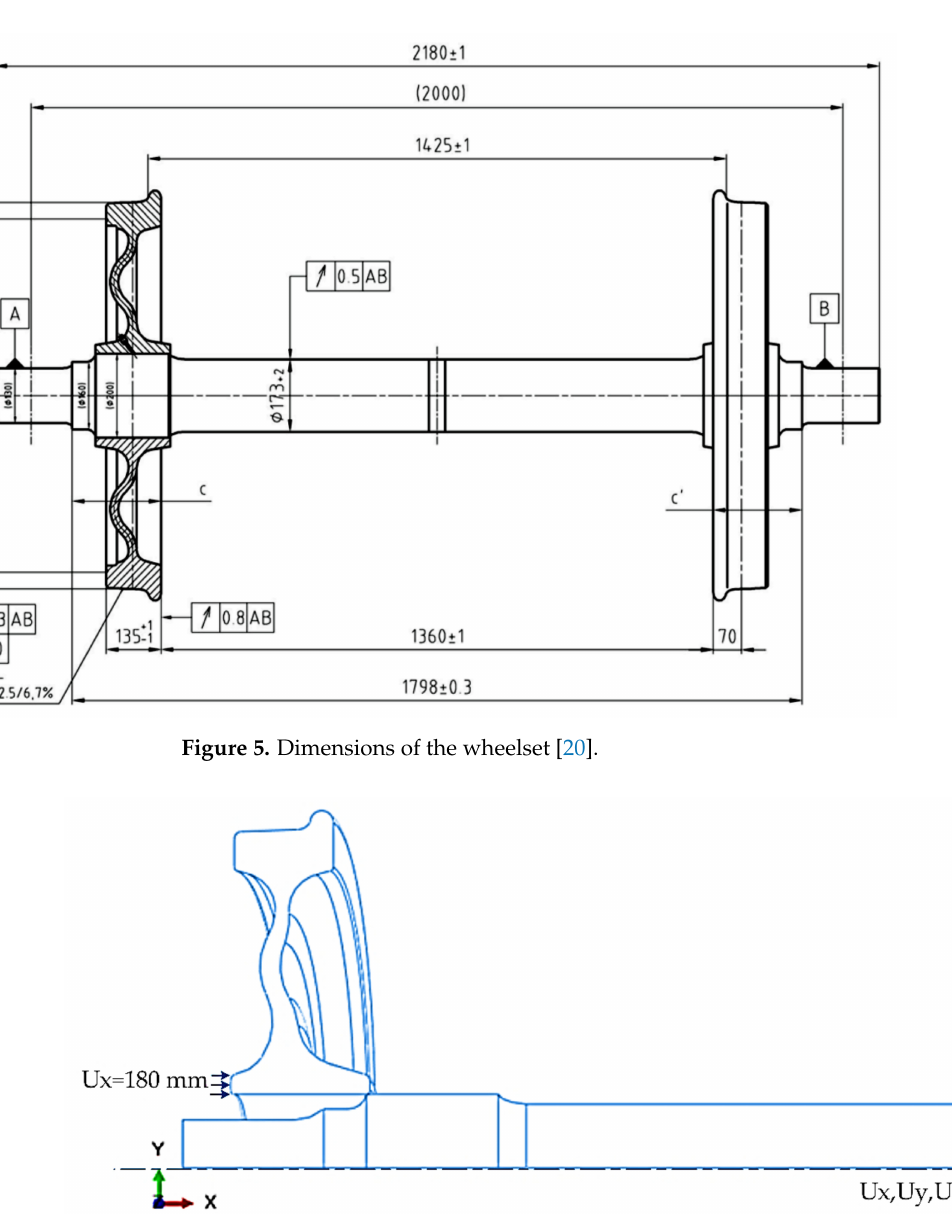
Figure 6. Boundary conditions.